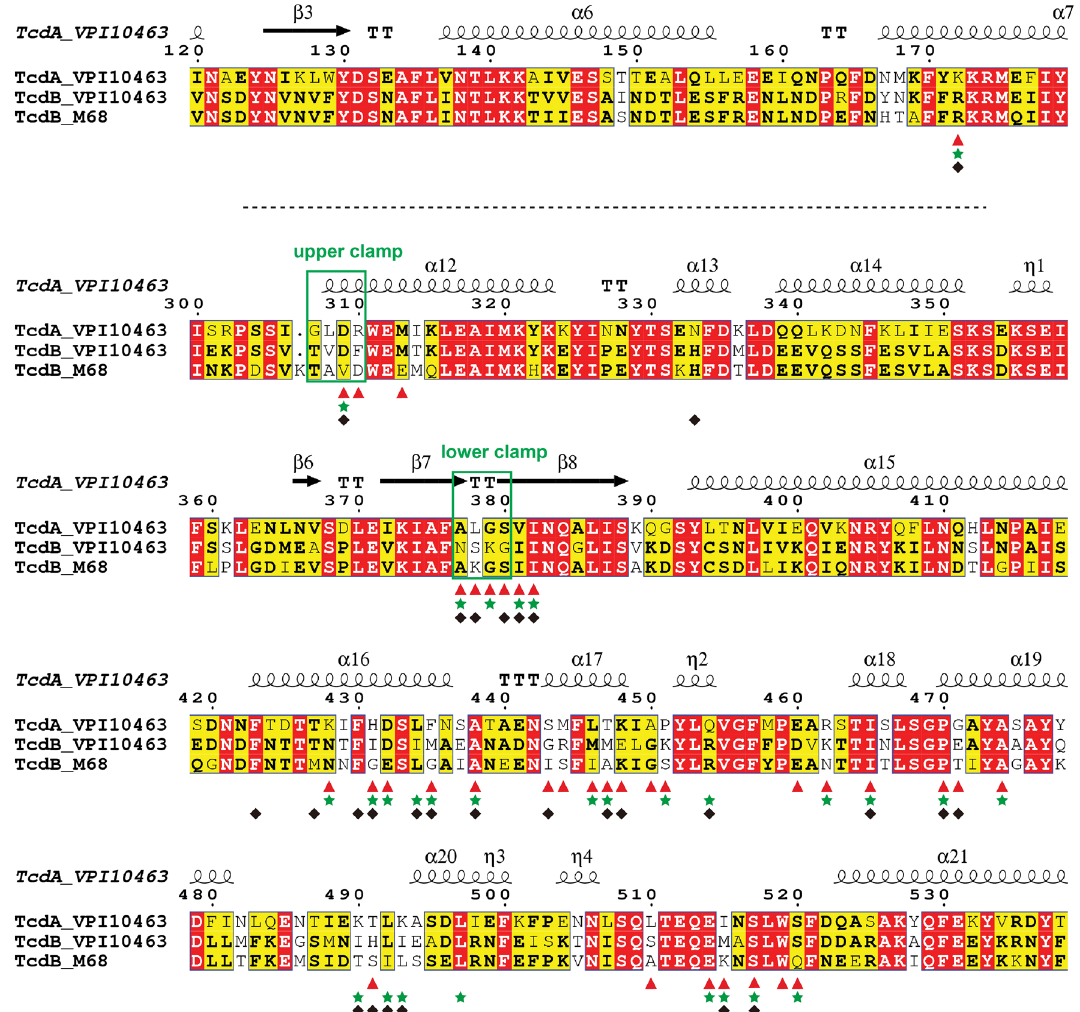
Figure 3. Amino acid sequence alignment among the GTDs of TcdA and two TcdB variants. Residue numbers and the secondary structures of the RhoA-bound GTD TcdA are shown on the top. The residues on the GTDs of TcdA-VPI10463, TcdB-VPI10463, and TcdB-M68 that interact with RhoA, Cdc42, and R-Ras are highlighted with red triangles, green stars, and black rhombuses, respectively. The green boxes highlight the upper and lower clamps of the